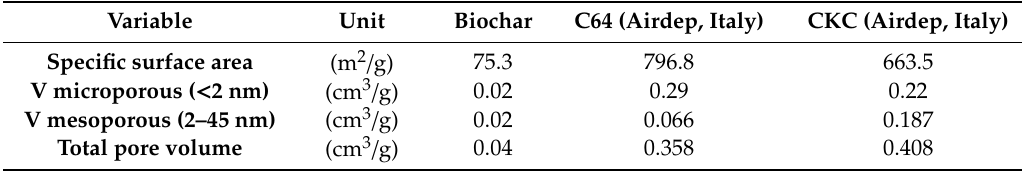
Table 3. Surface and volume (V) characteristics for the materials